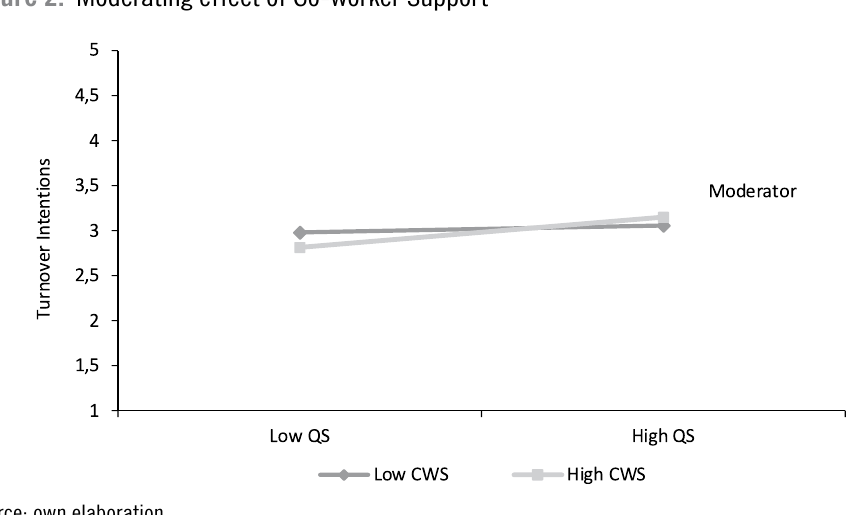
Figure 2. Moderating effect of Co-worker Support